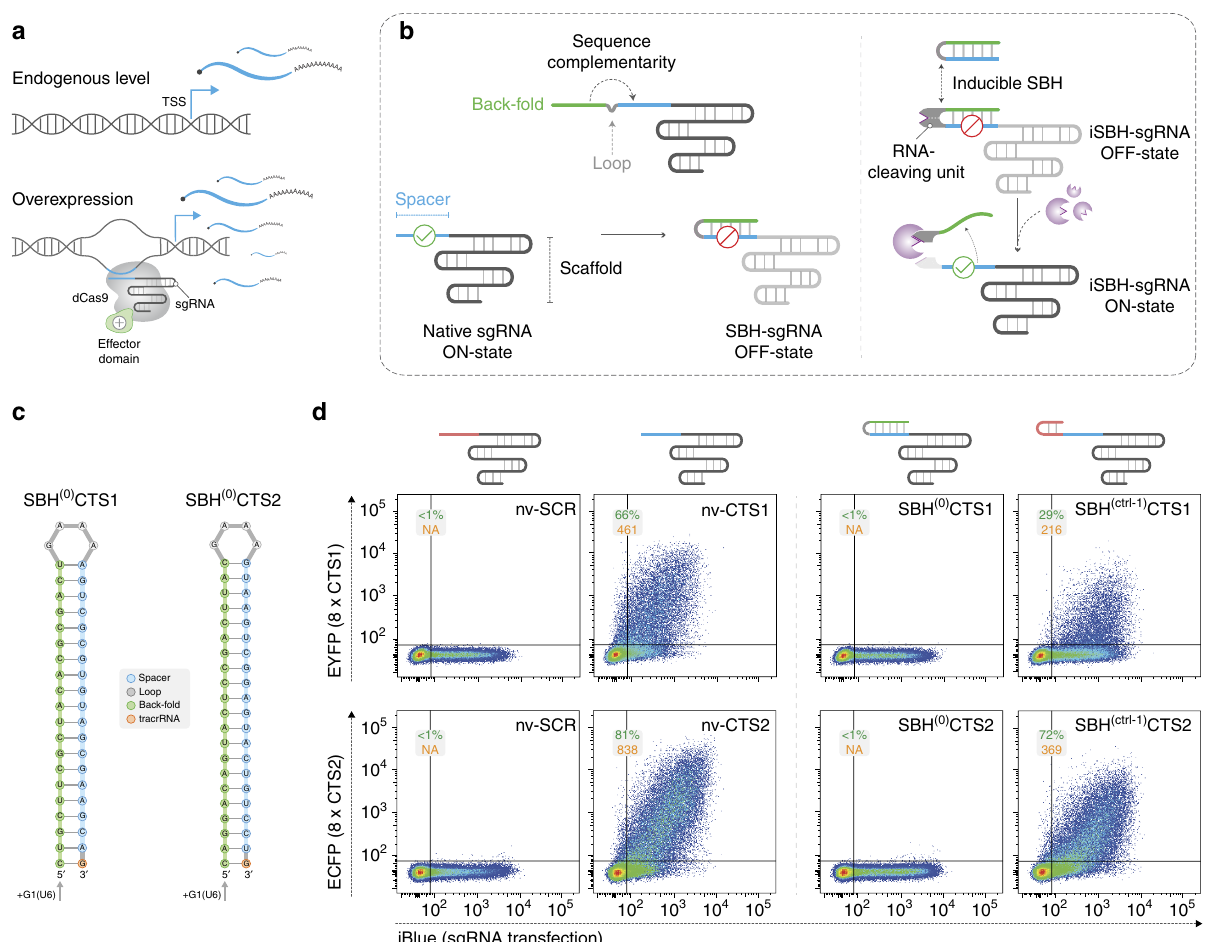
Figure 1 | Inhibition of CRISPR-TR activity by SBH-sgRNAs. ( a ) Schematic representation of CRISPR-TR-based transcriptional modulation. ( b ) Conceptual framework underlying the design of inducible sgRNAs for the control of CRISPR-TR activity. Appending a back-fold extension to the 5 0 end of the native sgRNA promotes the formation of a spacer blocking hairpin (SBH) expected to switch the sgRNA to a quiescent state (OFF-state) (left). Replacing the basic loop with conditional RNA-cleaving units enables generation of inducible SBH designs (iSBH), which can restore CRISPR-TR activity in the presence of specific inducers (spacer release) (right). ( c ) Sequence and secondary structure of prototype SBH designed to silence sgRNAs with spacer targeting CTS1 (left) and CTS2 (right). Superscript annotation ((0)) denotes the number of free spacer nucleotides. þ G1(U6) refers to the G nucleotide required for U6 transcription. ( d ) HEK-293Tcells were co-transfected with dCas9-VP64, reporter 8xCTS-mCMVp-EYFP and the following sgRNAs: nv-SCR (native sgRNA with scramble spacer sequence); nv-CTS (native sgRNA targeting CTS1 or CTS2); SBH (0) CTS (SBH-sgRNAs with full CTS spacer coverage); and SBH (ctrl-1) CTS (control SBH-sgRNAs with accessible CTS spacers and offset 5 0 end 10nt hairpin structure). Flow cytometric analysis (48h post transfection) revealed complete SBH-mediated inhibition of CRISPR-TR activity relative to native and control sgRNAs (see also Supplementary Fig. 2b). Representative flow cytometry scatter plots show reporter activation (EYFP, ECFP channel) plotted against sgRNA transfection (iBlue channel). Flow cytometry plot insets display % of activated cells (double iBlue þ ve and EXFP þ ve , green) and median reporter fluorescence intensity for this population